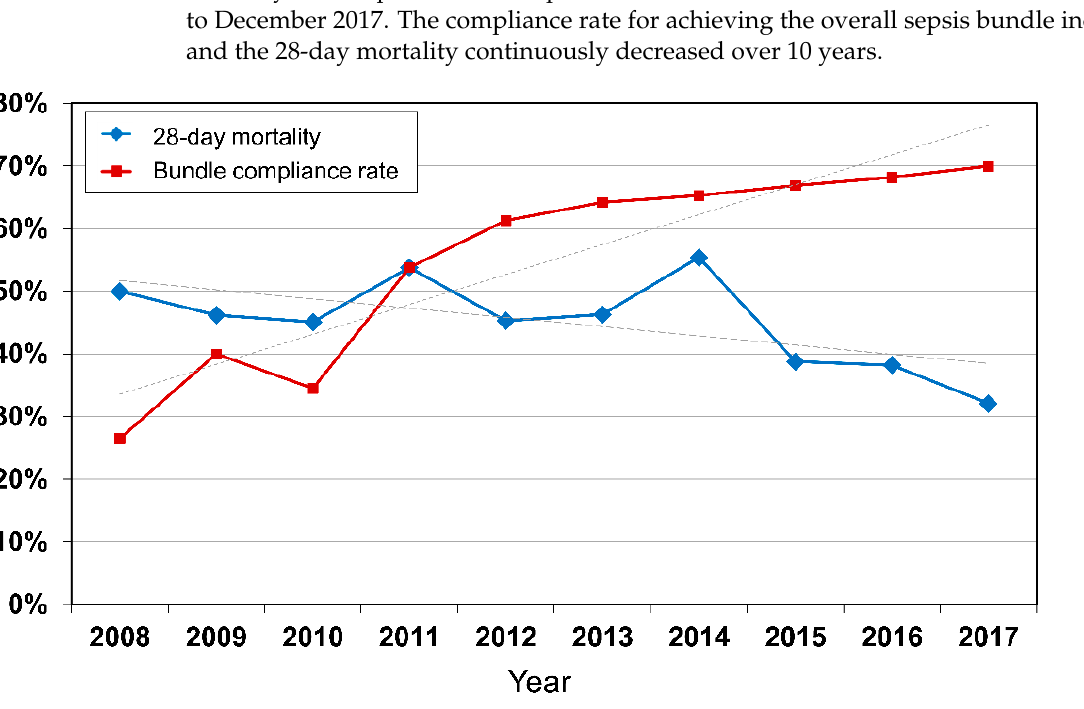
bundle group. Table 2. Management of shock over the initial 6 h ( n = 976) . Variables